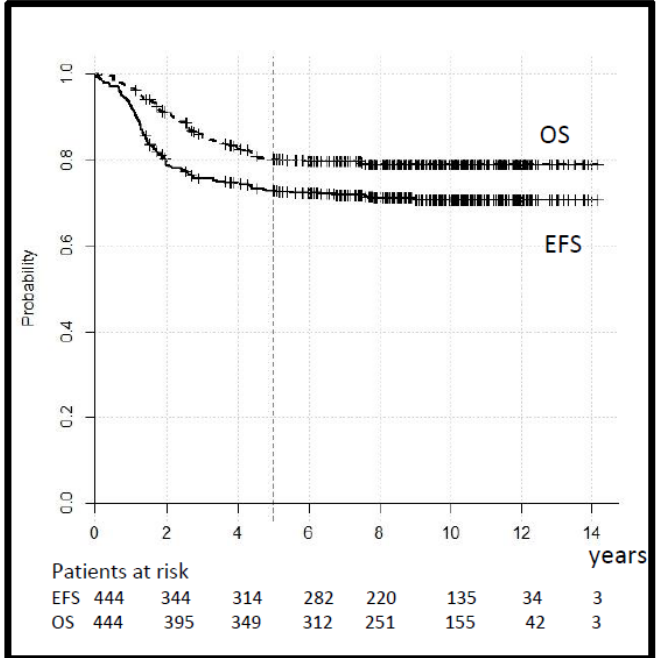
Figure 3. Legend: event-free and overall survival (EFS and OS) for all patients.